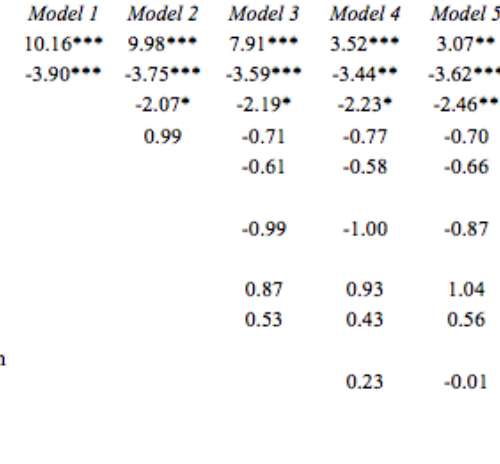
S ummary of Multilevel Regression Analyses for Predicting Emotional Exhaustion by Perceived Support in Special Education Teachers (Standardized